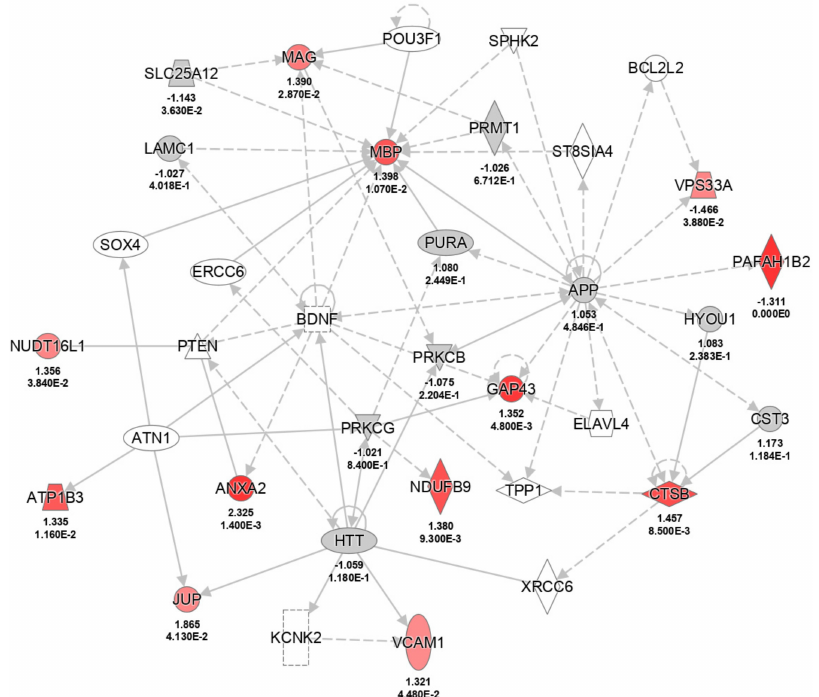
Figure 5. Ingenuity pathway analysis (IPA)-visualization of the network “nervous system devel- opment and function, cell death and survival, tissue morphology”. Proteins fitting the parameter p < 0.05 and fold change of 1.3 are highlighted in different shades of red according to the significance ( p -value) of the difference between WT mice and mutant